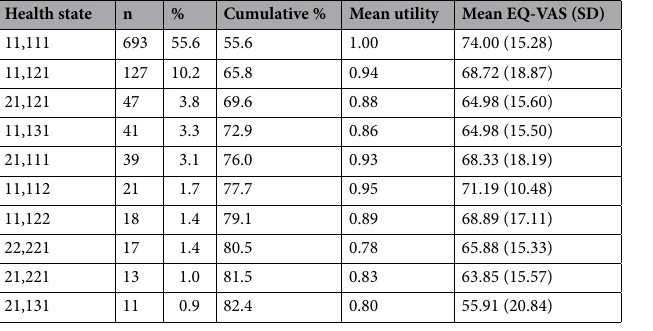
Table 3. The 10 most frequently reported EQ-5D-5L health states with mean utility scores and EQ-VAS values (n =